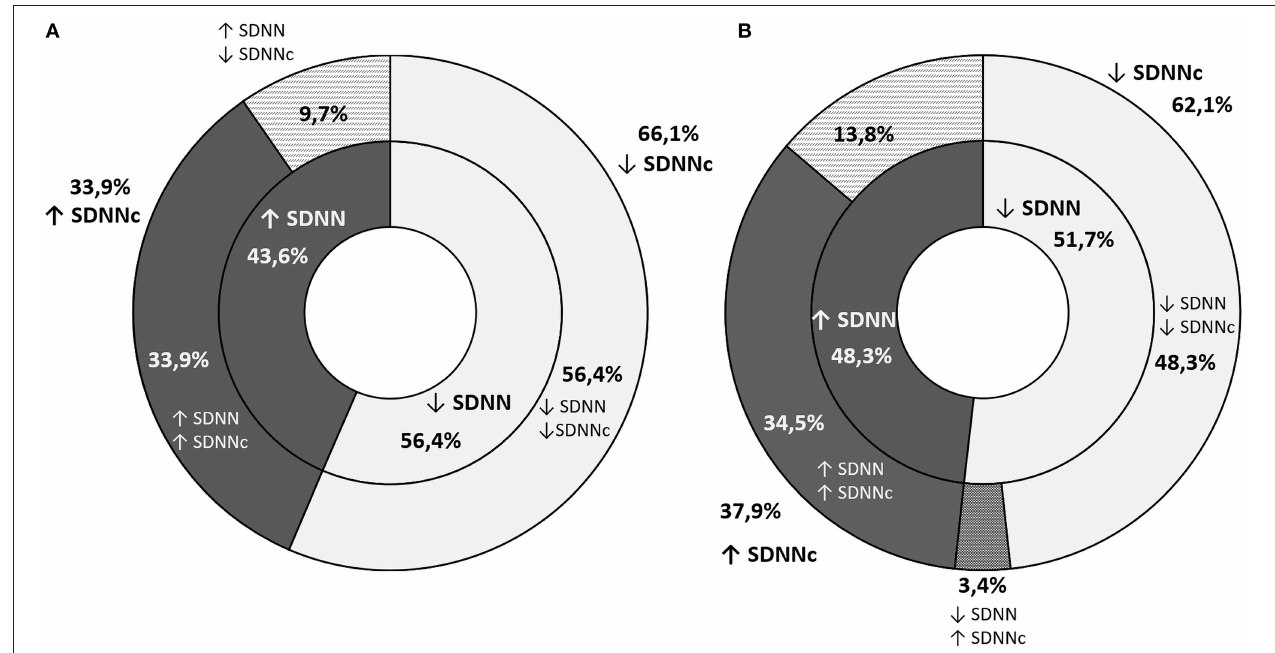
FIGURE 3 | A graphic representation of the proportion of students with an increase or decrease in SDNN (inner ring) and SDNNc (outer ring) throughout the observation period (A) graph stands for boys and (B) one for girls.